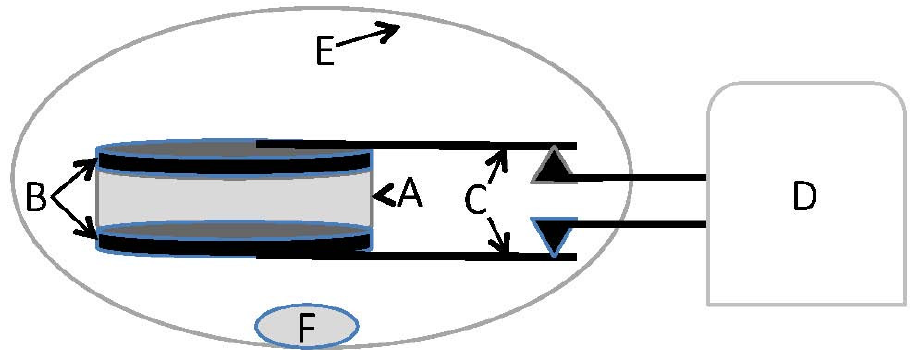
Figure 10. Testing geometry galvanostat: A—Dielectric Material, variable thickness; B—Grafoil electrodes, 0.04 cm thick × 5 cm diameter; C—Grafoil “wires”, ~10 cm length; D—Galvanastat (BioLogic 300); E—1 liter volume zip lock plastic bag; F—DI water ‐ saturated paper towel.